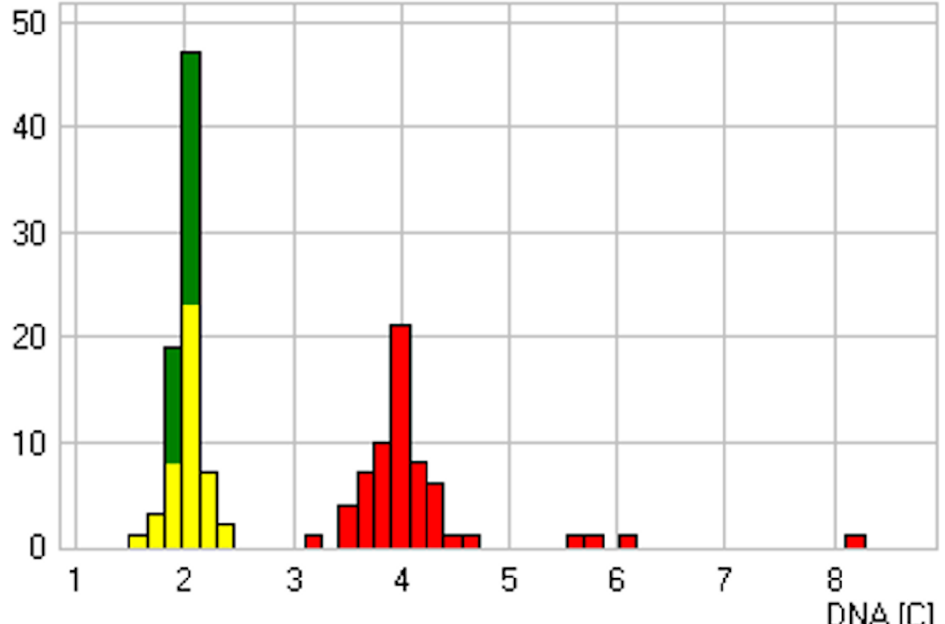
Figure 2. Sample with a doubtful cytological diagnosis and euploid – polyploid DNA histogram. Two euploid DNA stemlines at 2c and 4c and single cells with DNA contents up to 8.3c are shown. DNA content in c-units ( x -axis), number of cells ( y -axis), reference cells (green), analysis cells (red), biggest stemline (yellow). In this patient case, a 66-year-old female patient showed an ulceration on the right edge of the tongue, which was histologically diagnosed as granulation tissue and healed after 6 weeks without irritation.